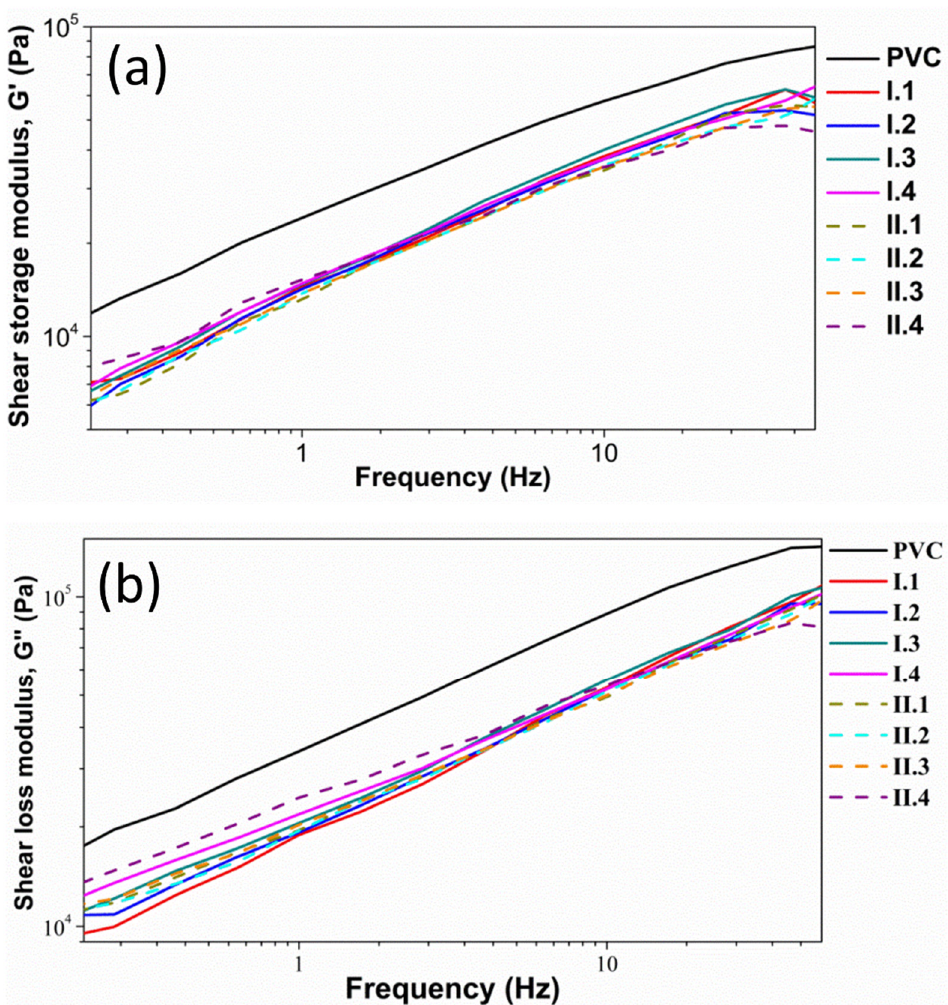
Figure 13 . ( a ) G ′ ; ( b ) G ″ of PVC and the PVC composites. The shear viscosity as a function of shear rate of Blank and all PVC composites are displayed in Figure 14. PVC showed the highest shear viscosity. The PVC composites Set II had higher shear viscosity than Set I since ZnSt in DB/ZnSt in composites Set I acts as a lubricant. The melt viscosity of all PVC composites and PVC did not observe a Newtonian plateau viscosity; however, they exhibited shear thinning profile at all shear rates. The higher shear rate, the more shear-thinning behavior. The increase in SiCO concentration reduced shear viscosity because capsicum oil acted as plasticizer and improved chain mobility of PVC since it decreased polymer concentration in the continuous phase [72]. The addition of silica concentration increased shear viscosity since the high surface area of silica particles improved interaction between PVC and silica which led to restricting polymer chain mobility [70]. However, the viscosity of the composites did not improve as regularly as was found in the work of Kamibayashi et al. [74] and Otsubo [75]. CO had a higher influence on shear viscosity than silica. It can be concluded that the shear viscosity of the PVC matrix decreased with increasing SiCO concentration.